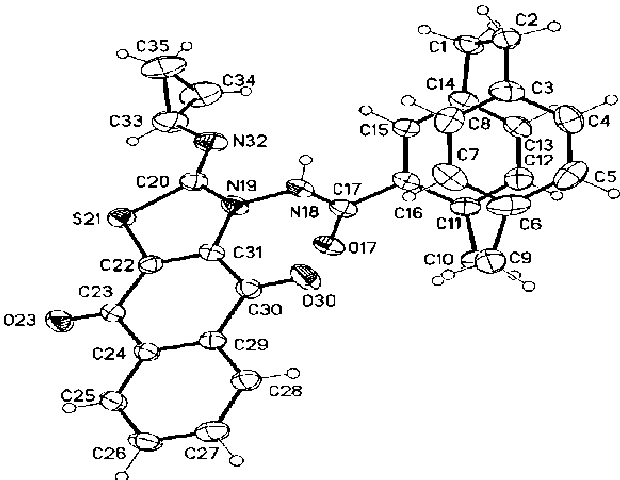
Figure 2. Molecular structure of compound 3e identified according to IUPAC nomenclature as ( Z )- N -(2-(cyclopropylimino)-4,9-dioxo-4,9-dihydronaphtho[2,3- d ]thiazol-3(2 H )-yl)-1,4(1,4)-dibenzo-